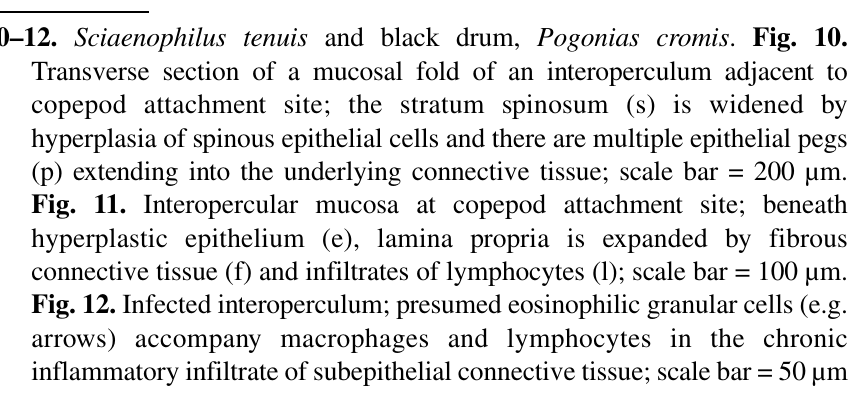
Figs. 10–12. Sciaenophilus tenuis and black drum, Pogonias cromis . Fig. 10. Transverse section of a mucosal fold of an interoperculum adjacent to copepod attachment site; the stratum spinosum (s) is widened by hyperplasia of spinous epithelial cells and there are multiple epithelial pegs (p) extending into the underlying connective tissue; scale bar = 200 µm. Fig. 11. Interopercular mucosa at copepod attachment site; beneath hyperplastic epithelium (e), lamina propria is expanded by fibrous connective tissue (f) and infiltrates of lymphocytes (l); scale bar = 100 µm. Fig. 12. Infected interoperculum; presumed eosinophilic granular cells (e.g. arrows) accompany macrophages and lymphocytes in the chronic inflammatory infiltrate of subepithelial connective tissue; scale bar = 50